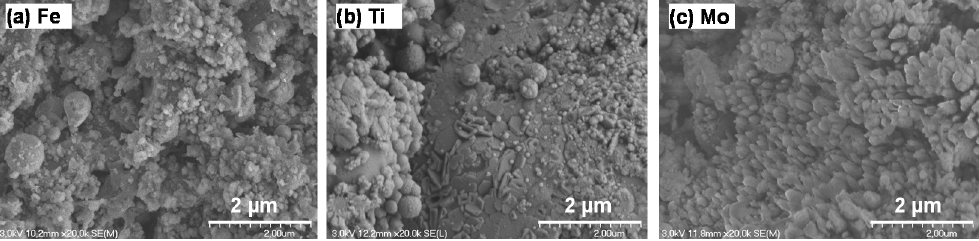
Figure 15. SEM images of coatings produced from Al powder and melamine on different substrates: ( a ) carbon steel, ( b ) Ti and ( c ) Mo, in ×20,000 magnification. Table 7. Surface roughness measurements of substrates and Table 7. Surface roughness measurements of substrates and coatings.